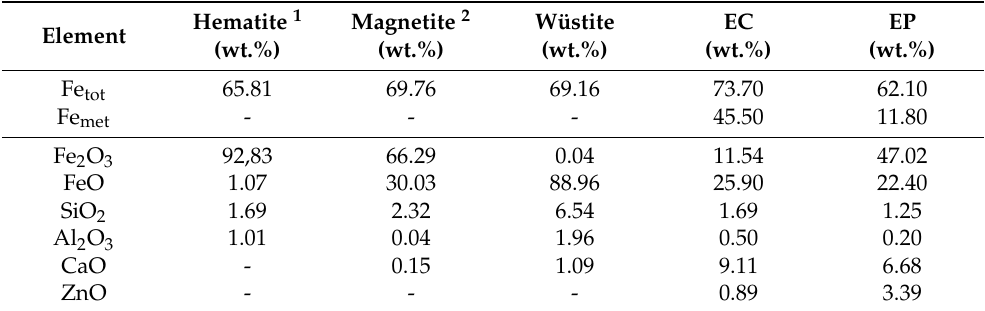
Figure 2. Drawing of the hollow graphite electrode and the steel crucible with an ignition pin. Table 1. Chemical composition of the feeding material.